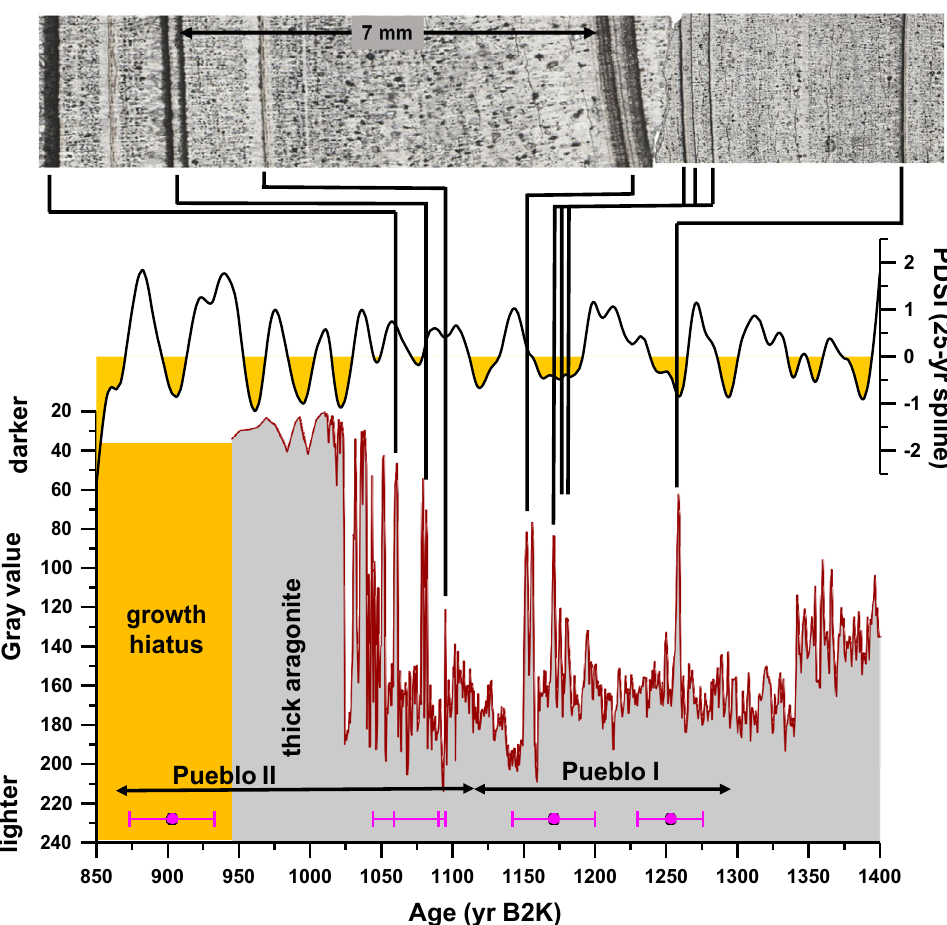
Figure 5. Gray time-series and thin section images through Pueblo I. ( A ) The thin section image shows the first cluster of aragonite (dark) layers after 1300 yr B2K illustrating the onset of drier conditions going into the Pueblo period. Several decades later, five aragonite layers (droughts) occur within a span of ~ 30 to 40 years (~ ≤ 8 years per drought defined by aragonite layers) starting at 1180 ± 125 yr B2K. The four dates in magenta between 1050 and 1300 yr B2K represent the timing of droughts from charcoal layers in ice deposits in Cave 29 of El Malpais National Monument 42 . The date at 913 yr B2K on charcoal attached to a corrugated pottery sherd also likely represents a drought 42 . All of these are comparable with droughts represented by aragonite layers